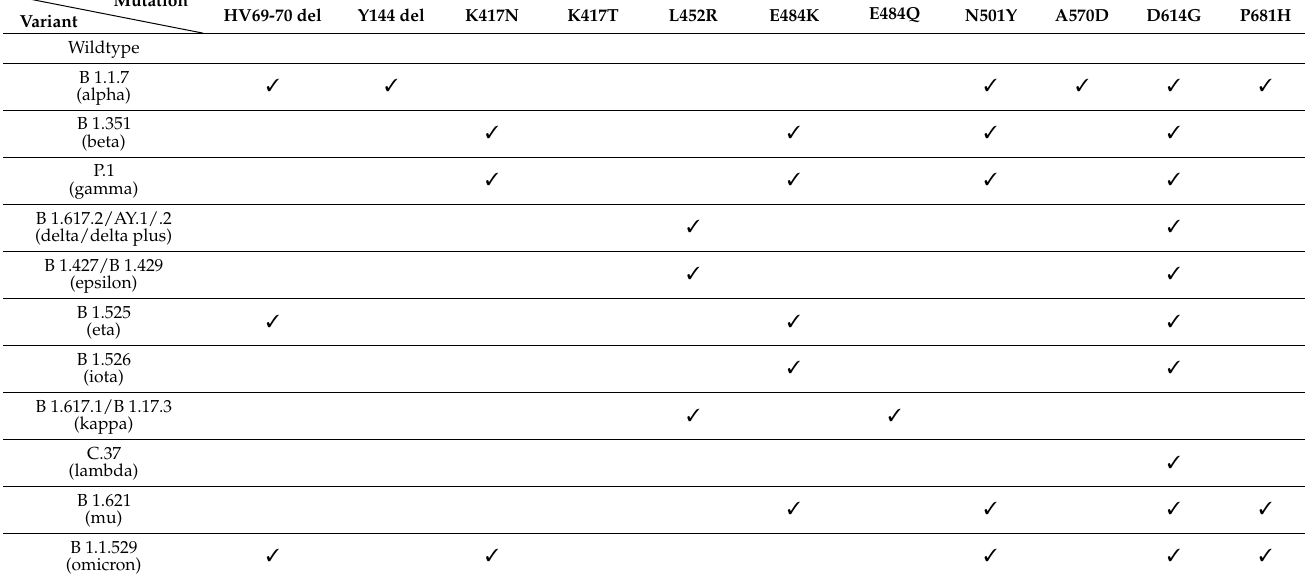
Table 1. Overview of the mutations tested by the competitive immunofluorescence assay with assignment to the different variants of